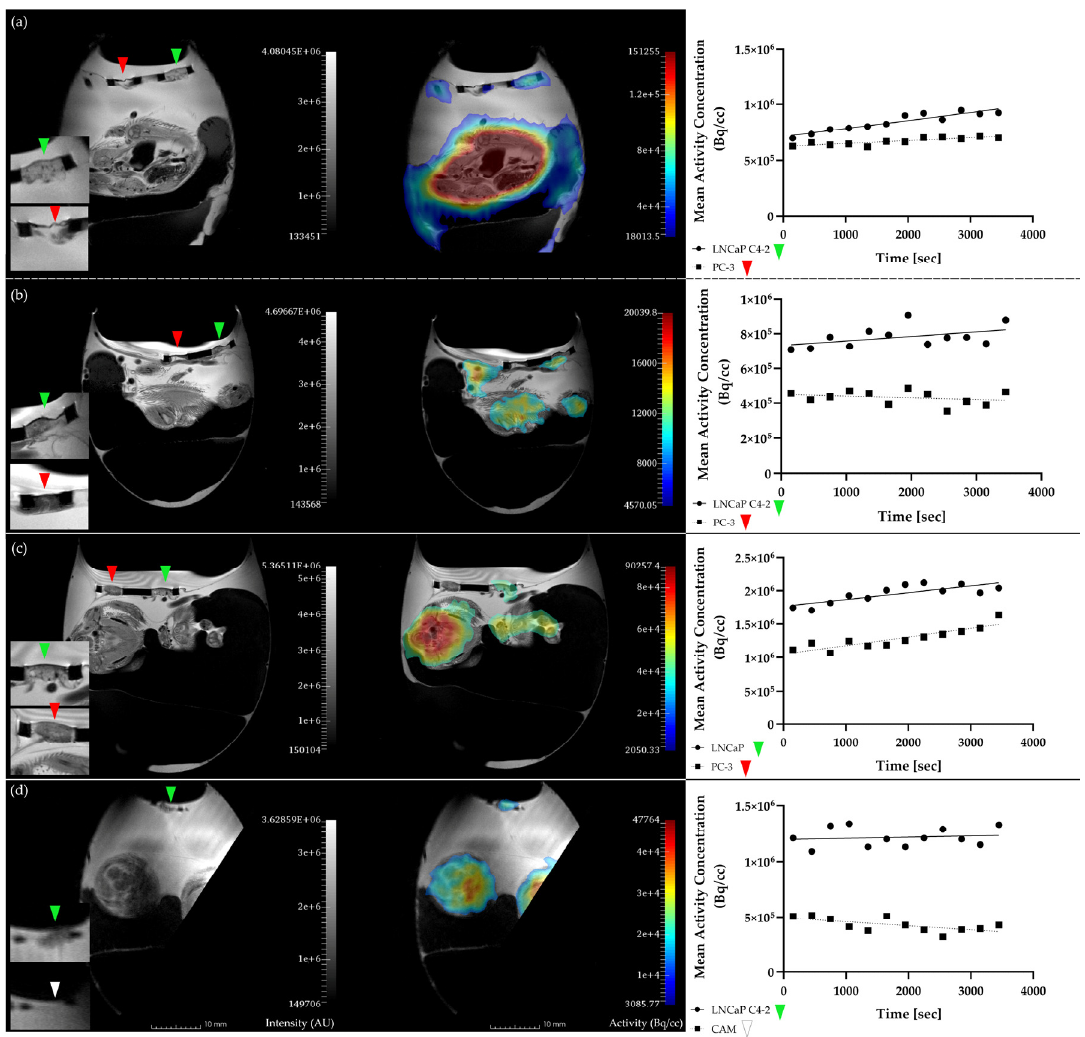
Figure 2. Magnetic resonance (MR) images (T2-weighted, TSE [28], left panel) and PET/MR fusion images (middle panel) of hen’s egg test–chorioallantoic membrane (HET-CAM) xenograft experiments with the corresponding time–activity curves for the respective PET region of interest (right panel). The PSMA-positive tumors can be clearly visualized in the MR image in all cases (( a , b , d ): LNCaP C4-2, ( c ): LNCaP), whereas the negative tumor PC-3 can only be seen in examples ( a – c ) and did not grow in example d (PSMA + → green arrow; PSMA − → red arrow; CAM → white arrow). Note the more intense accumulation in the PSMA-positive tumors as compared to the PSMA-negative tumors, suggesting target-specific tracer accumulation.